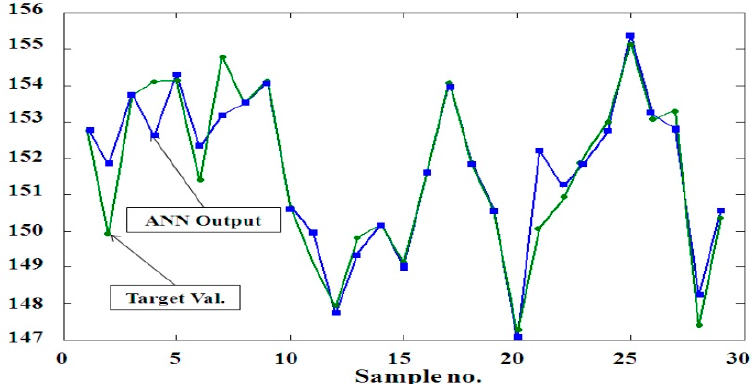
Figure 12. Trained Artificial Neural Network (ANN) standard output vs. target plot to (TaTS1).